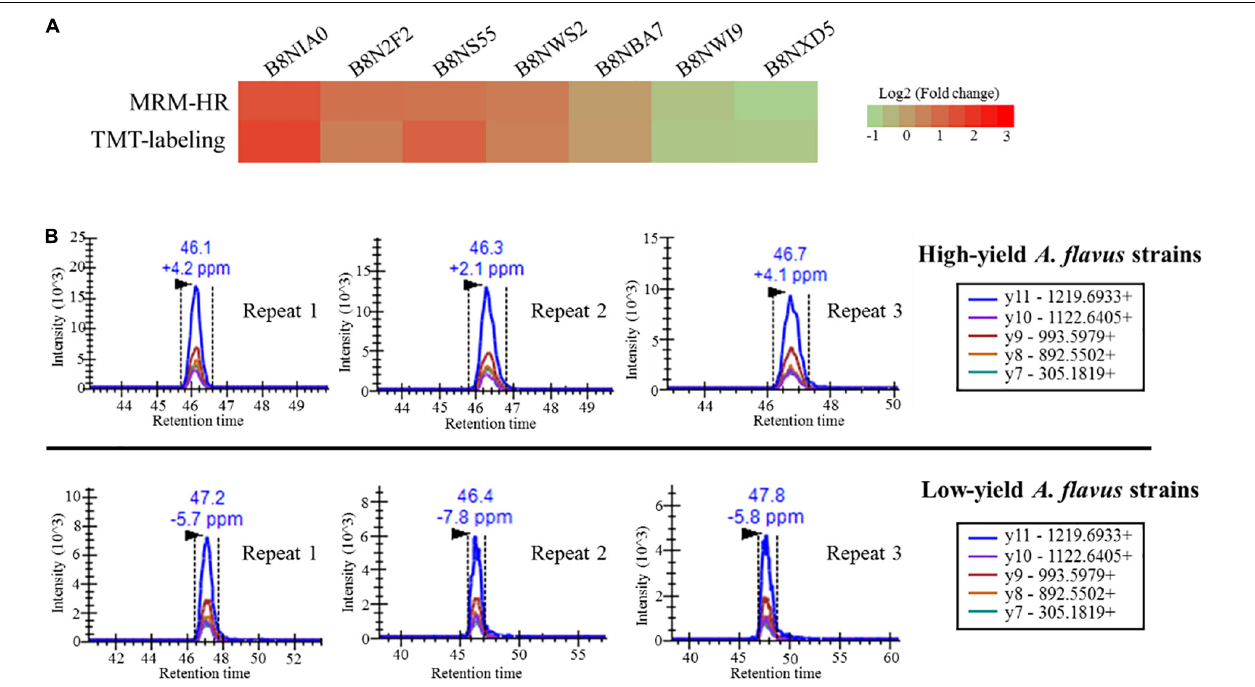
FIGURE 6 | High-resolution multiple reaction monitoring (MRM-HR) verification of candidate proteins. (A) Heatmap showing the ratio of nine peptides from relevant candidate proteins obtained using MRM-HR and the TMT-labeling method. (B) Representative MRM-HR chromatograms of the peptide DVGIVGLPVTWDR from glucose-6-phosphate isomerase (B8NBA7). Quantification analysis using high-performance liquid chromatography coupled with tandem mass spectrometry. Chromatograms were obtained in the MRM-HR mode. The upper and lower three chromatograms represent the three biological replicates for high- and low-aflatoxin-yield A. flavus strains,